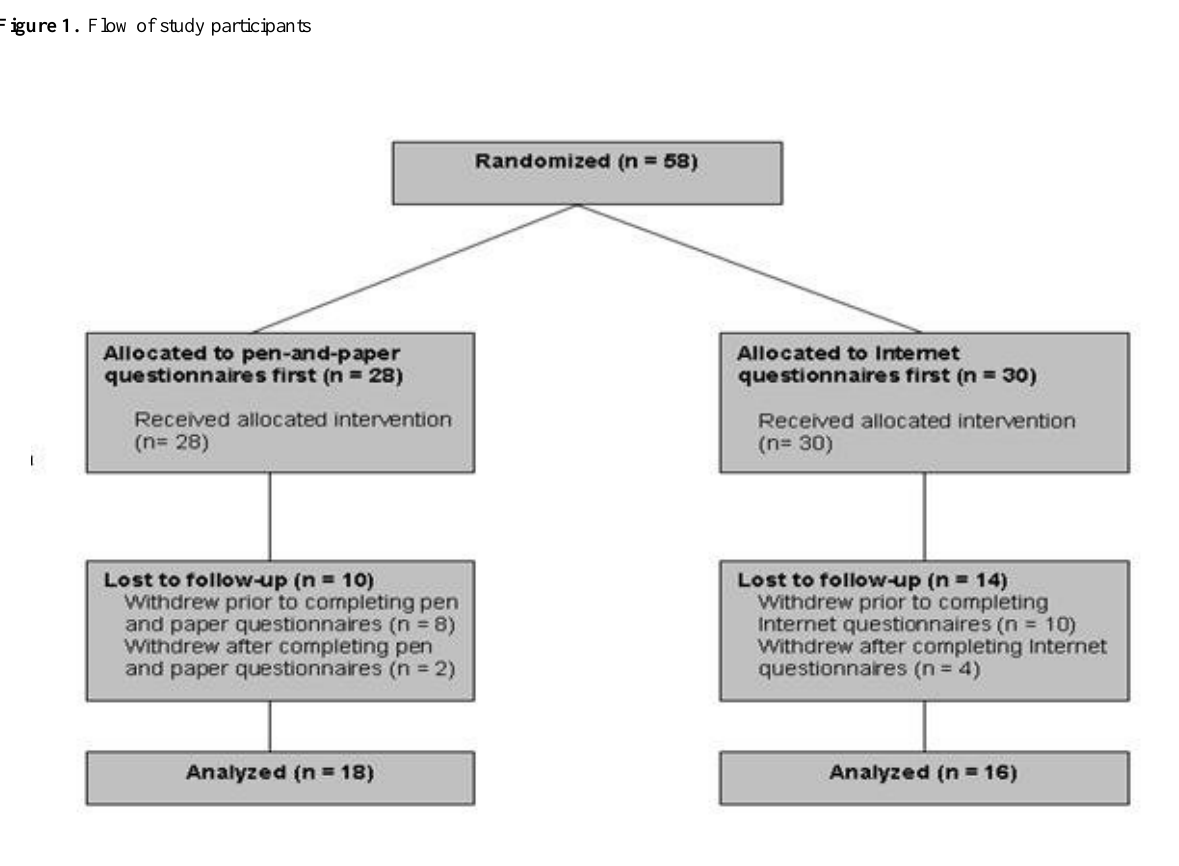
Table 1. Demographics of participants